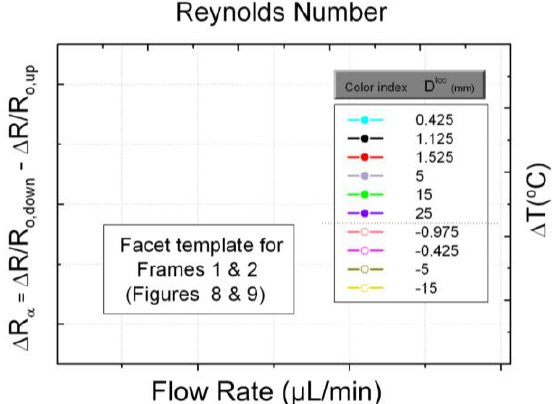
Figure 7. Description of the template which applies for all facets used in the frames. On the left y-axis ΔR is shown, while the corresponding ΔT is shown on the right y-axis. The α bottom and the top x-axis show the flow rate and the Reynolds number respectively. In the legend, the correspondence between the line color and the distance of each sensing element to the heater is